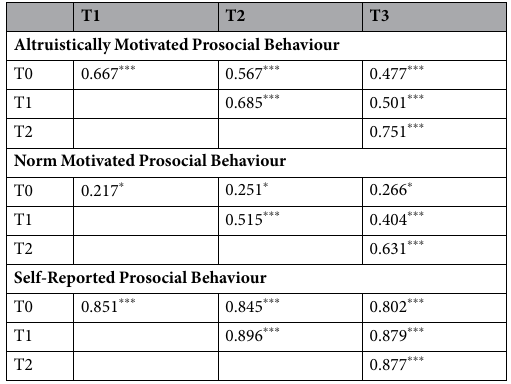
Table 3. Re-test reliability (correlation coefficients) for scores on the three factors of prosociality in the retest control cohort (RCC). *** Indicates significant correlations at p < 0.001 (2-tailed), * p < 0.05